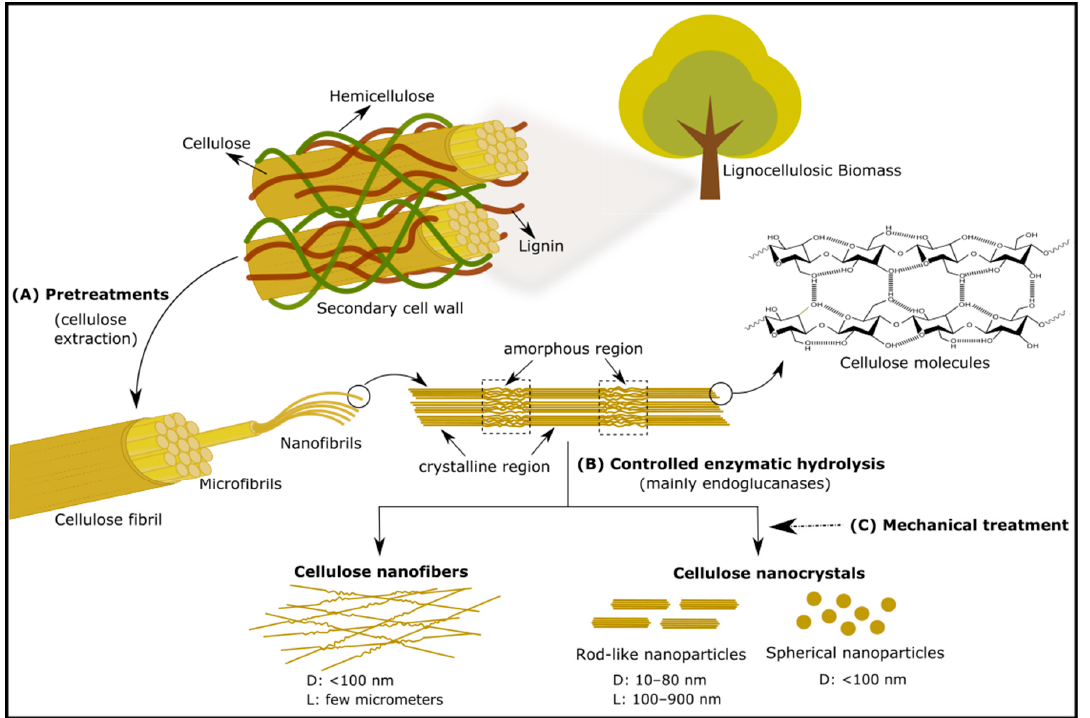
Figure 1. Process for nanocellulose (NC) production through enzymatic hydrolysis. ( A ) Pretreatments of the lignocellulosic biomass for cellulose extraction; ( B ) Controlled enzymatic hydrolysis for production of cellulose nanofibers and cellulose nanocrystals (rod-like and spherical) and their respective sizes; ( C ) Indication of the possible application of mechanical treatment after enzymatic hydrolysis, usually employed to obtain more uniform particles.